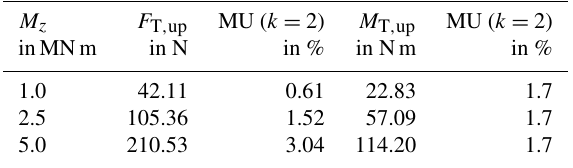
Table 4. Measurement uncertainty of FT and TM at different load steps for the upper